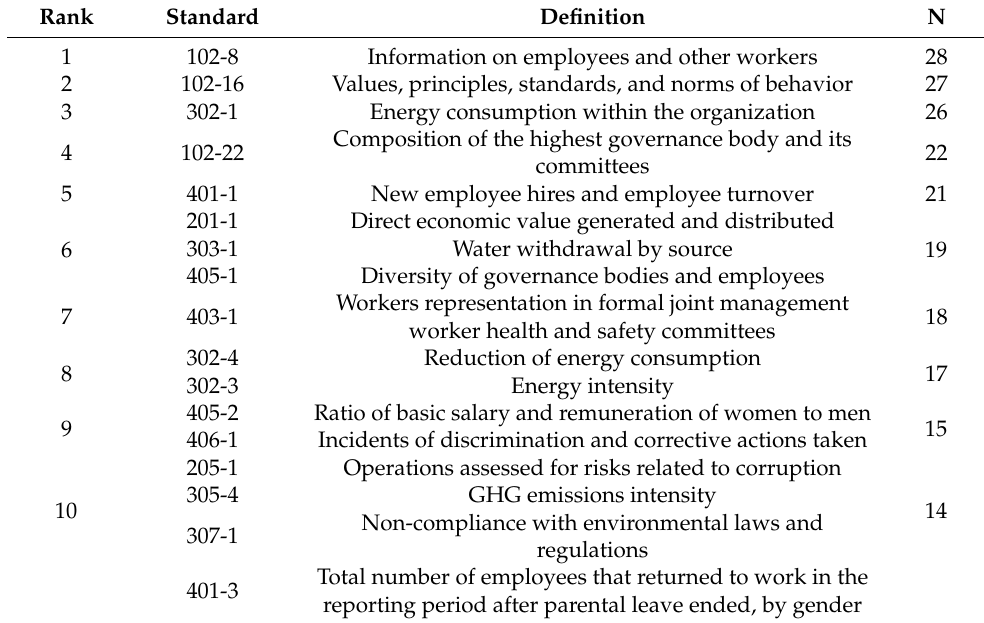
Table 3. Top 10 ranking of GRI